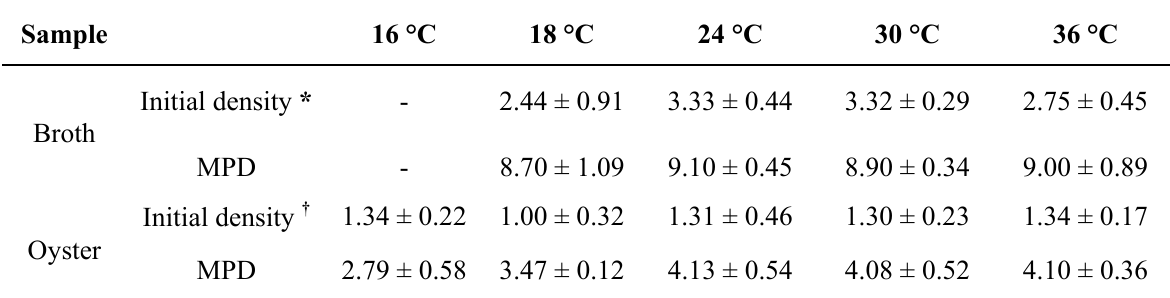
Table 4. Comparisons of maximum population density (MPD) of natural V. vulnificus in oyster and inoculated V. vulnificus (ATCC 27562) in